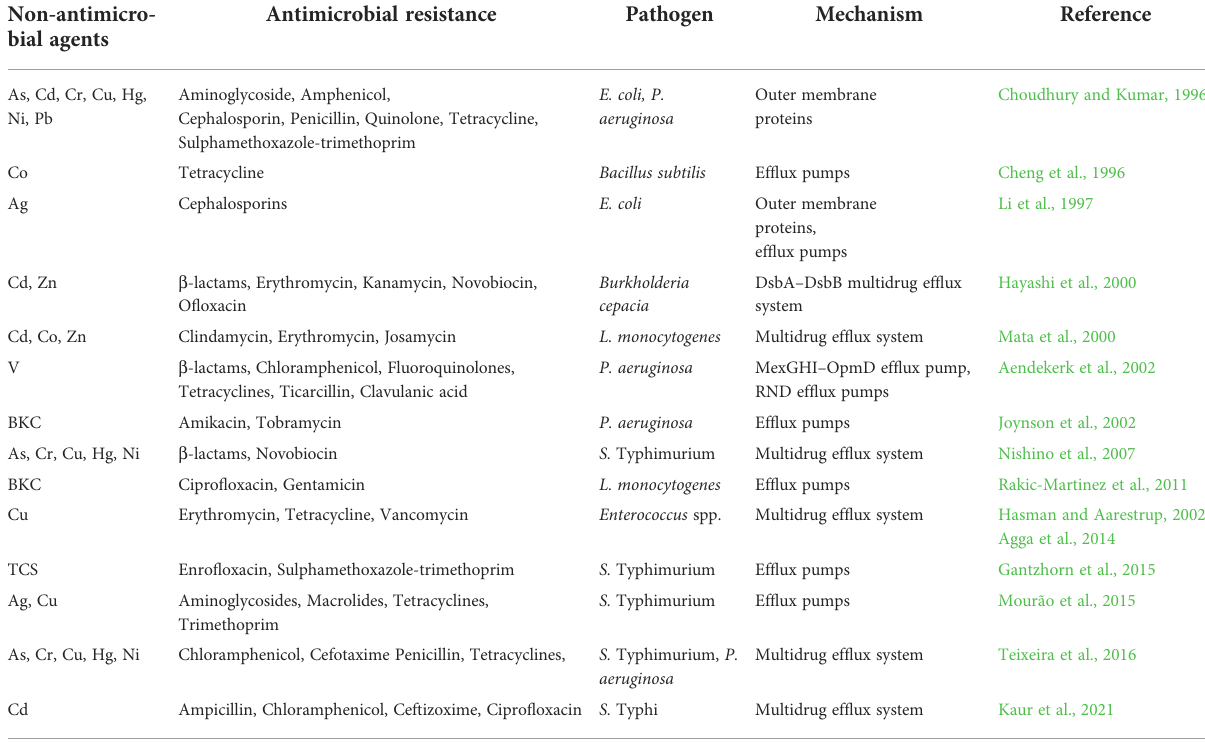
TABLE 1 Components of non-antimicrobial agents that induce cross-antimicrobial resistance among pathogenic bacteria. Non-antimicro- bial